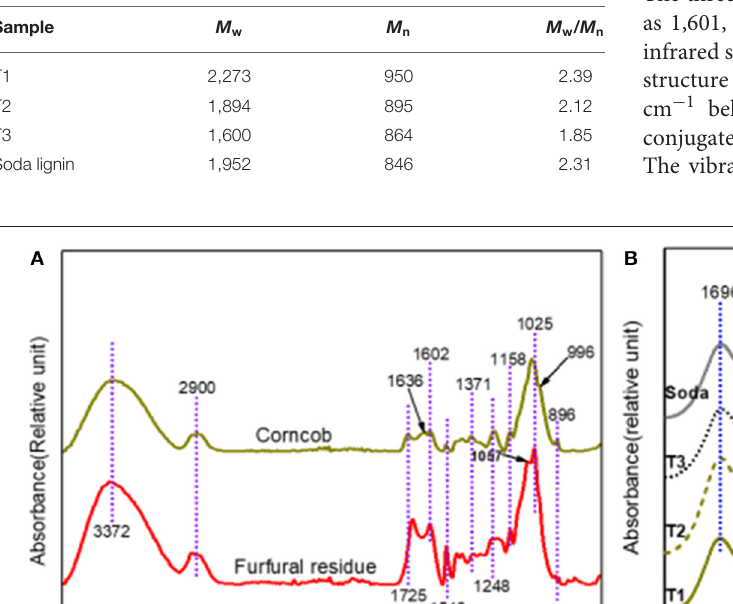
Frontiers in Energy Research |